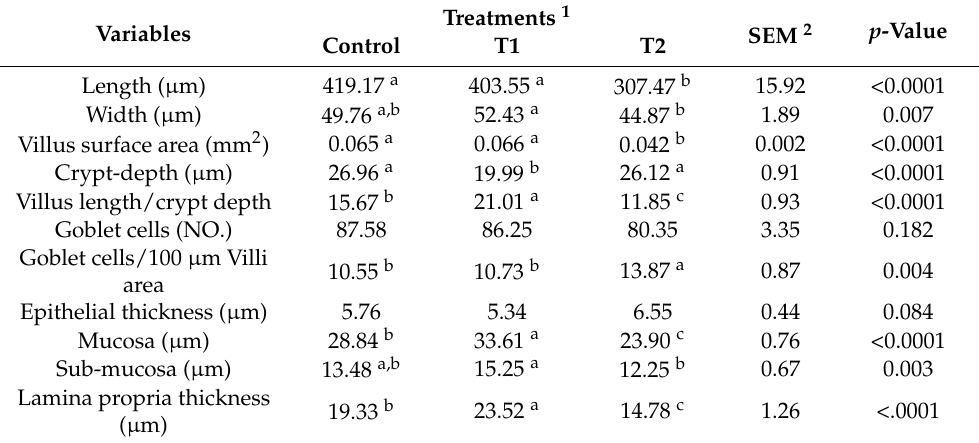
Table 8. Effect of Tribulus Terrestris (TT) supplementation on histomorphometric measurements of ileum in broiler chickens.